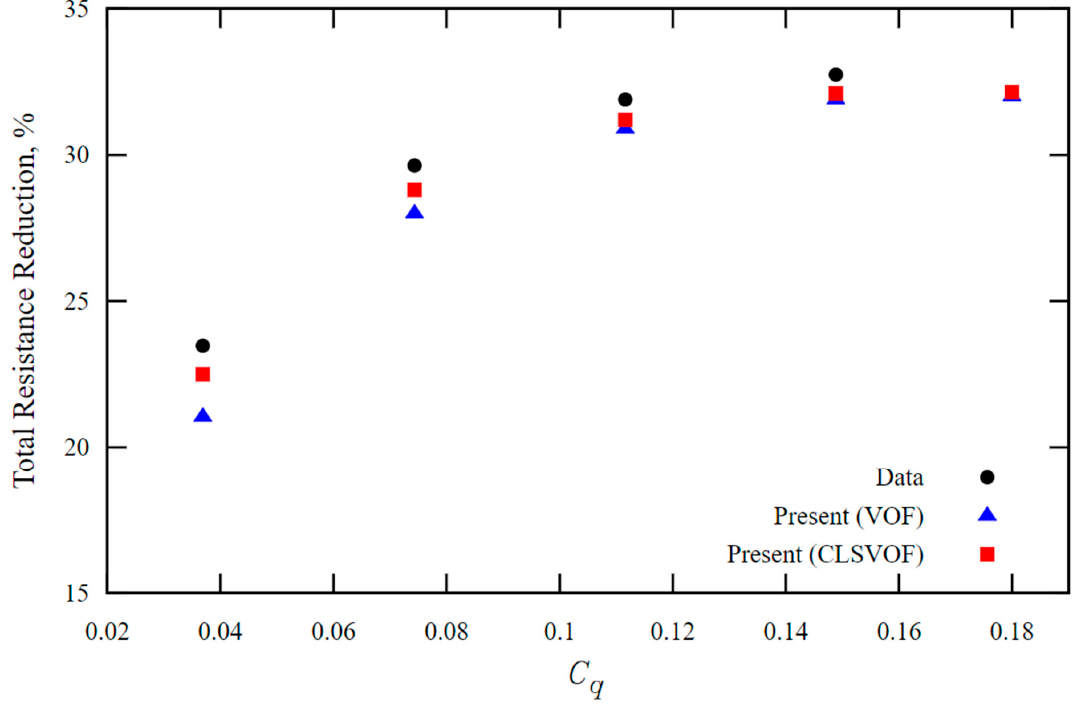
Figure 14. Total drag reduction at various injected air flow rates.